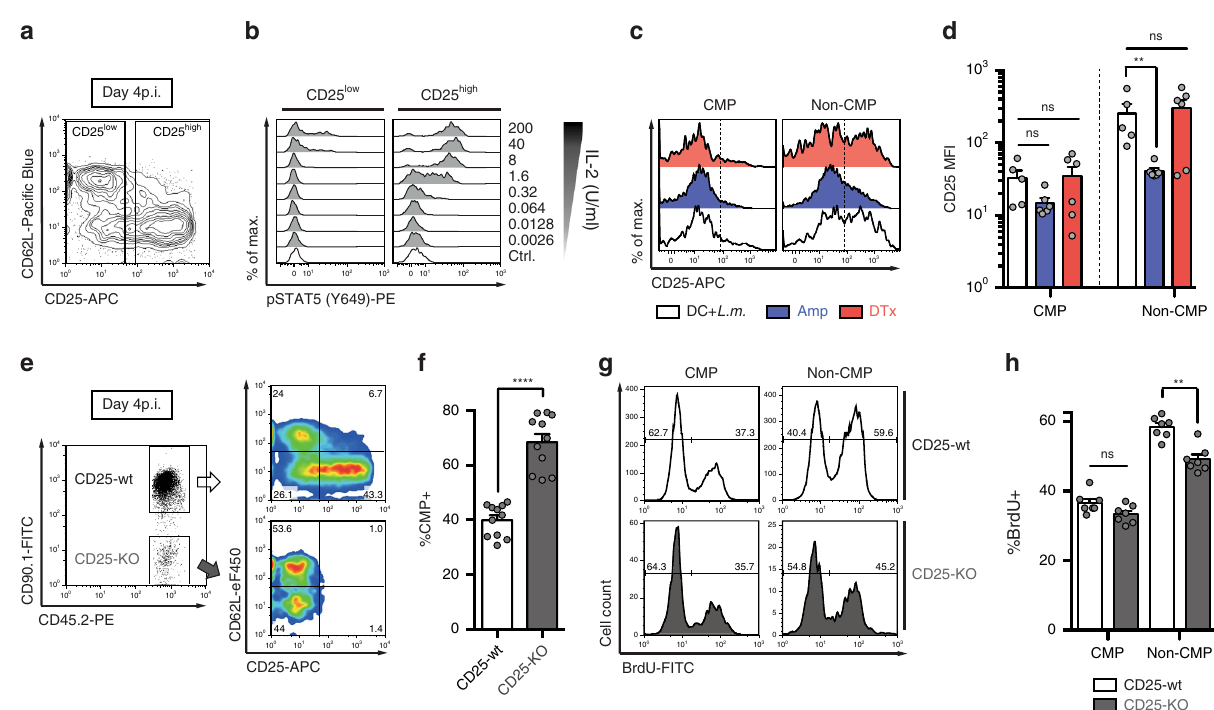
Fig. 5 In fl ammation-driven IL-2-responsiveness supports faster proliferation of non-CMPs. a Representative contour plot showing expression of CD62L and CD25 for progenies derived from 10 4 naïve OT1 cells at day 4 after DC + L.m . immunization. b As in a , but splenocytes were stimulated ex vivo with titrated amounts of IL-2 for 15 min. Overlayed histograms showing pSTAT5 (Y649) for CD25 low and CD25 high subsets of transferred OT1 cells. c As in a , but mice were either left untreated (DC + L.m .; n = 5) or received DTx ( n = 6) or Ampicillin (Amp; n = 6) treatment. Histograms showing expression of CD25 for the indicated subsets. d Bar graph depicts the CD25 median fl uorescent intensity (MFI) values. e – h 5 × 10 4 naïve CD25-wt (CD45.1 − / − CD90.1 + / + ) and 5× 10 4 naïve CD25-KO (CD45.1 − / − CD90.1 − / − ) OT1 cells were transferred into CD45.1 + / + CD90.1 − / − recipients, followed by DC + L.m . immunization. BrdU was injected 3 h before analysis. e Representative dot plot showing the gating strategy for transferred OT1 cells (pre-gated: CD8 + CD45.2 + CD45.1 − ), with corresponding pseudo-colour plots showing expression of CD62L and CD25. f Bar graph depicts the percentage of CMP cells ( n = 11). g Representative histograms showing the BrdU pro fi les of the indicated subsets. h Bar graph depicts the percentage of BrdU + cells ( n = 7). Lines depict the mean, error bars the s.e.m. ** P < 0.01, **** P < 0.0001 (Mann – Whitney test). Data are from two independent experiments. Source data are provided as a Source Data fi